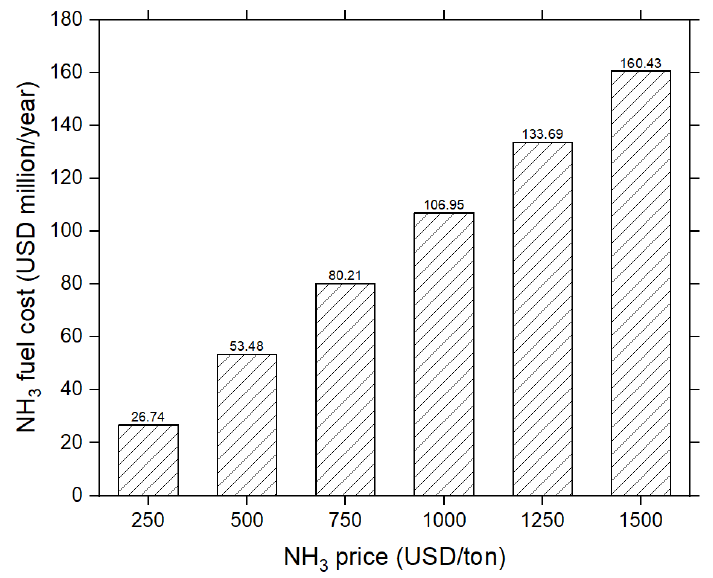
Figure 9. Fuel cost for the NH 3 price.